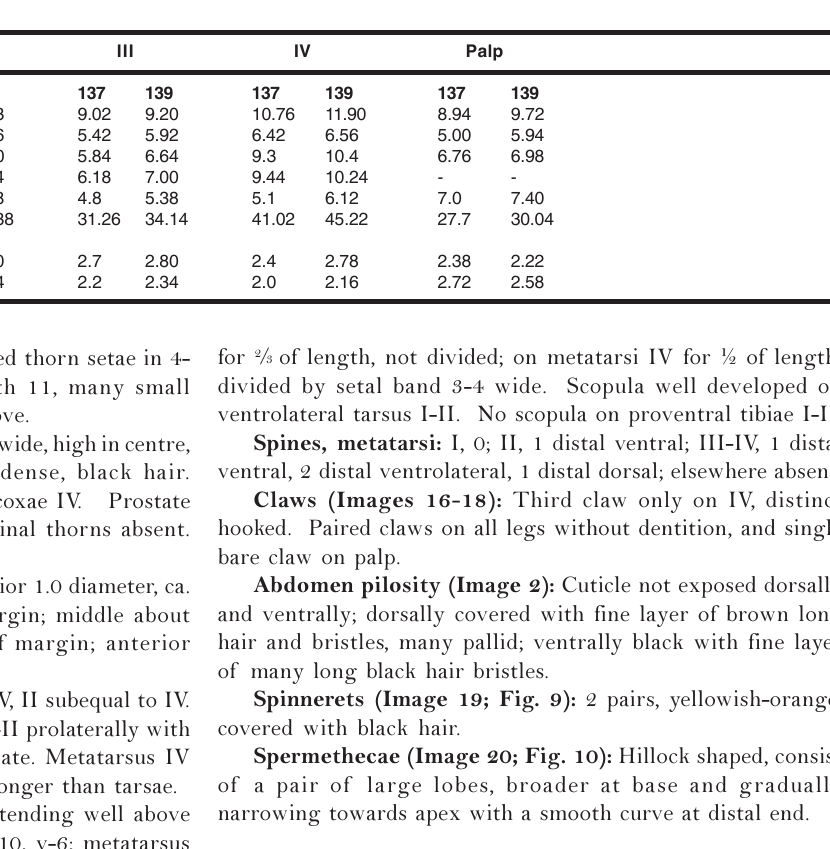
Table 1. Morphometry of legs and palp of Thrigmopoeus truculentus Pocock, 1899, WILD-06-ARA-137 (137), WILD-06-ARA- 139 (139) (measurements in